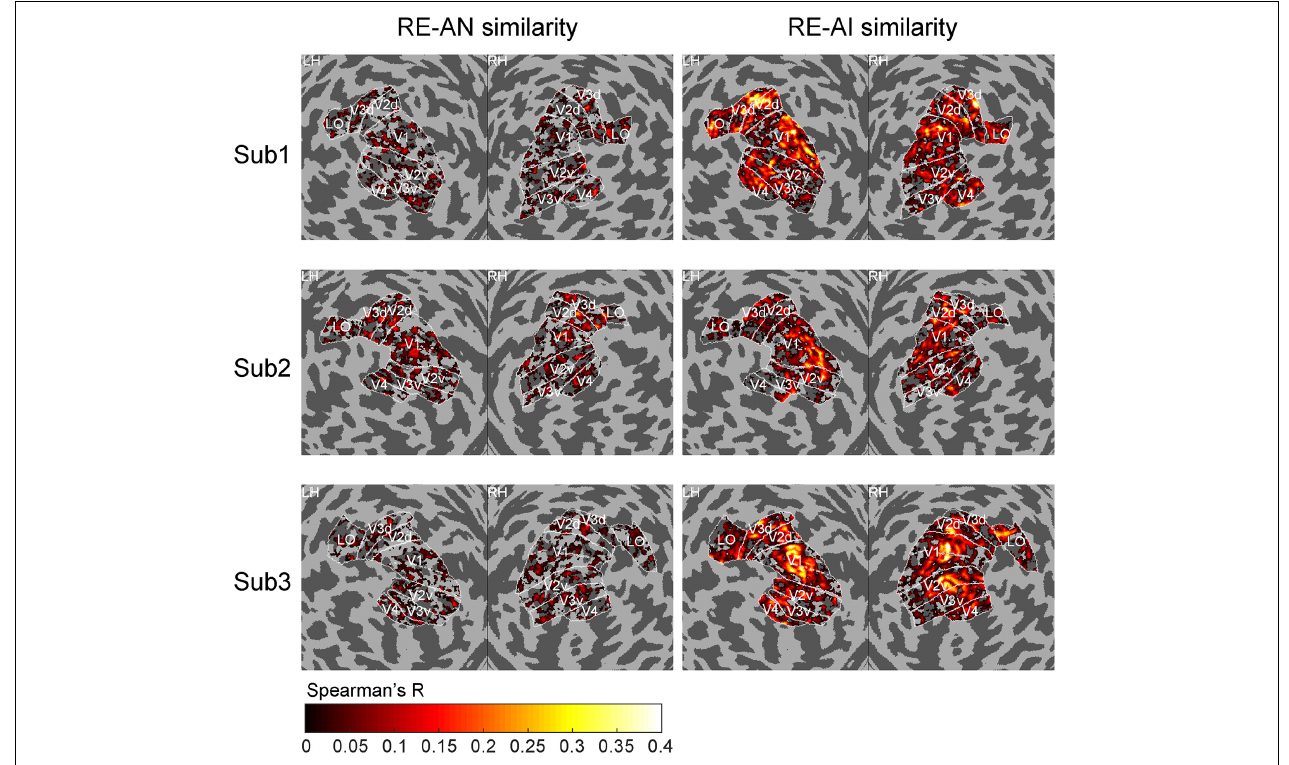
FIGURE 4 | Cortical topology of RE-AI and RE-AN similarities. The RE-AI similarities are overall higher than the RE-AN similarities across all early visual areas in the human